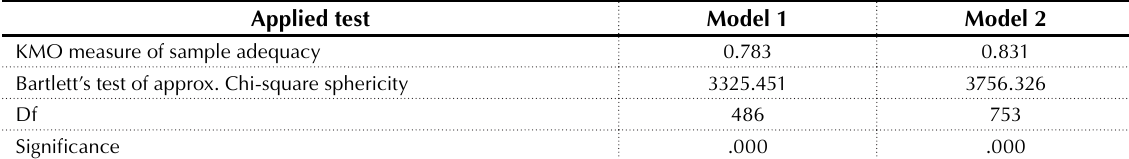
Table 5. Comparison of KMO and Bartlett tests